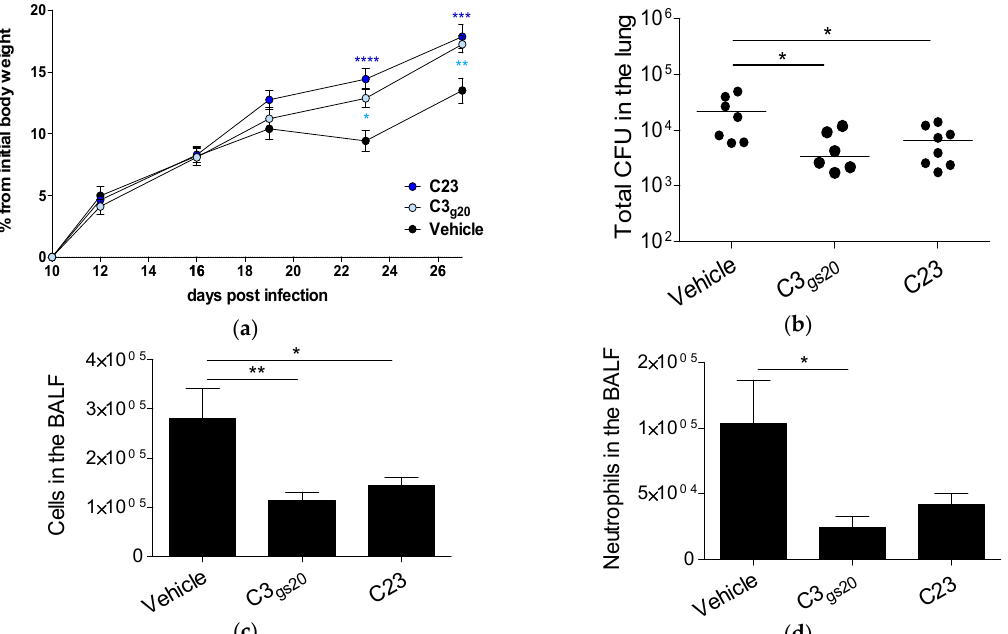
Figure 5. Modulation of the host response by synthesized HS competitors in a mouse model of long-term chronic P. aeruginosa lung infection (28 days). C57Bl/6NcrlBR mice were intratracheally injected with 1–2 × 10 6 CFUs of the P. aeruginosa isolate AA43 embedded in agar-beads. Mice were treated subcutaneously with HS competitors (30 mg/kg) or vehicle every day starting from ten days post-infection. At the sacrifice, BALF and lung were recovered. ( a ) Changes from initial body weight were calculated for each group of mice at regular intervals. ( b ) Total CFUs in the lungs were evaluated. ( c ) Total cell and ( d ) neutrophil recruitment was analyzed in BALF. The data are pooled from at least two independent experiments ( n = 20–26). CFUs in individual mice are represented as dots and horizontal lines represent median values. The other parameters are represented as mean ± SEM. Statistical significance is indicated: * p < 0.05, ** p < 0.01, *** p < 0.001, **** p < 0.0001. Table 3. Levels of cytokines and chemokines in murine lungs during chronic P. aeruginosa lung infection (28 days) and subcutaneous treatment with C3 gs20 or C23 (30 mg/kg). Level (pg/500 µg Lung) p Value Cytokine/Chemokine